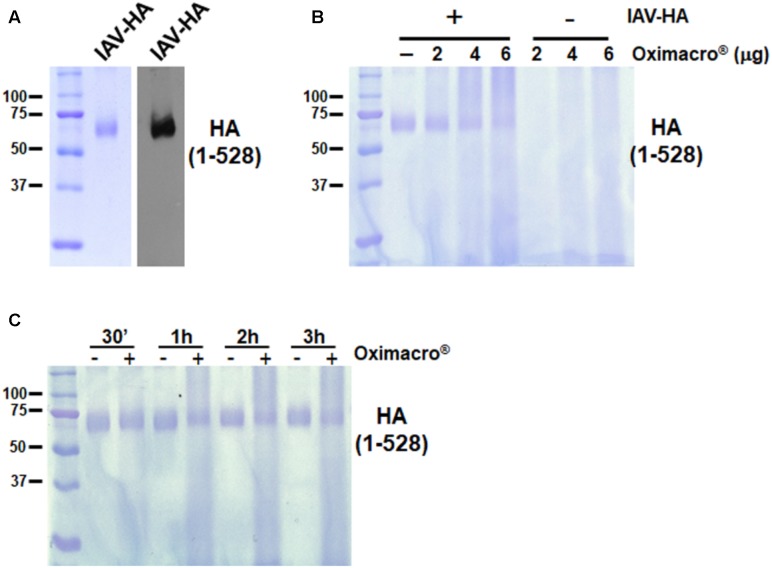
Oximacro® interacts with the recombinant extracellular domain of IAV HA. (A) SDS–PAGE and immunoblot analysis of recombinant IAV-HA glycoprotein. Purified HA protein was analyzed on 10% SDS-polyacrylamide gels. Gel was either stained with Coomassie blue or analyzed by immunoblotting with an anti-HA IAV mAb. Left panel: Coomassie blue-stained gel of 1 g of purified recombinant HA-IAV. Right panel: Immunoblot analysis with 200 ng of the same sample as in the left panel. (B,C) Oximacro® interacts with recombinant HA in a concentration- (B) and time-dependent (C) manner. (B) Purified recombinant HA-IAV (1 g) was incubated at 37°C with medium or increasing amounts of Oximacro® for 3 h, and then mixtures were analyzed by SDS–PAGE. (C) Purified recombinant HA-IAV (1 g) was incubated at 37°C for various lengths of time with medium or 6 g of Oximacro®. At 30 min, 1, 2, and 3 h of incubation, mixtures were analyzed by SDS–PAGE. Gels were then stained with Coomassie blue. Sizes are indicated in kilodaltons.